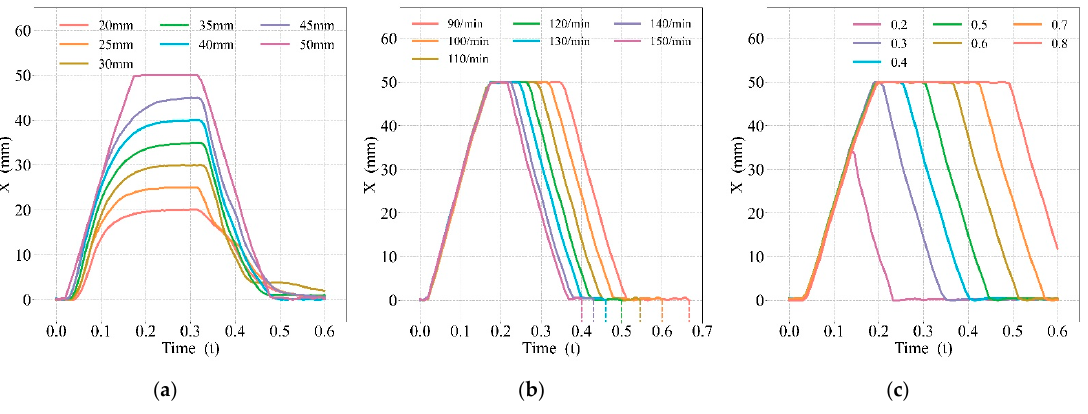
Figure 9. Prototype mechanical waveforms under various instructions: ( a ) various depths, ( b ) various frequencies, ( c ) various duty cycles. Table 2. Piston movement characteristics under various instructions.